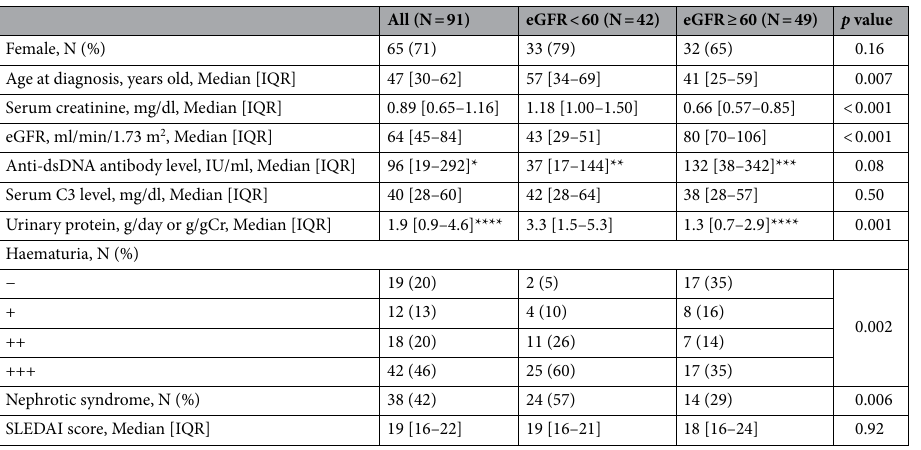
Table 1. Baseline characteristics (N = 91). Number of missing data: *N = 27, **N = 10, ***N = 17, ****N = 1. N number; interquartile range, IQR, eGFR estimated glomerular filtration rate, SLEDAI systemic lupus erythematosus disease activity